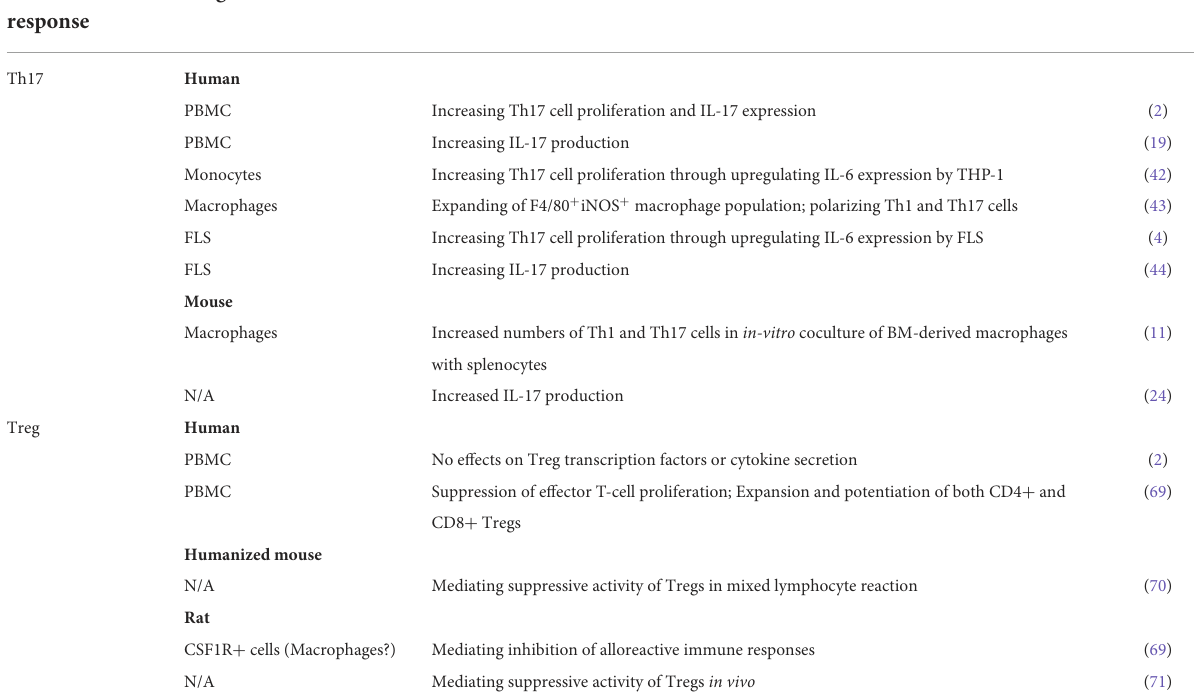
TABLE 1 Effects of IL-34 on T lymphocyte